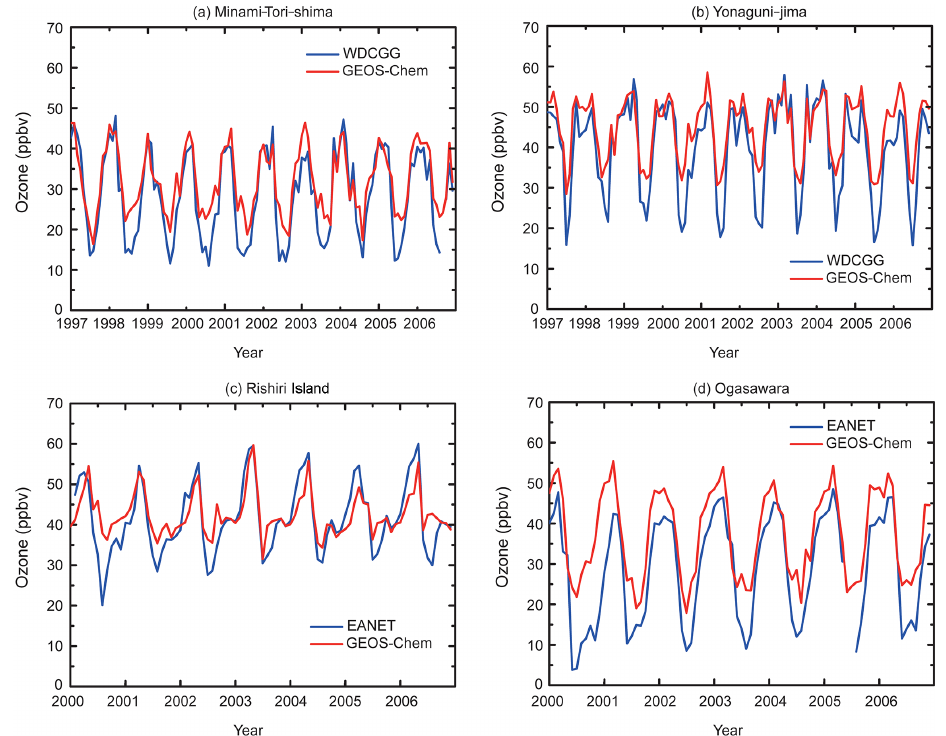
Figure 3. The time series of monthly surface-layer O 3 mixing ratios measured by WDCGG and EANET (the blue line) and simulated by MetEmisB (the red line). (a) Minami-Tori-shima and (b) Yonaguni-jima are WDCGG sites, and (c) Rishiri Island and (d) Ogasawara are EANET